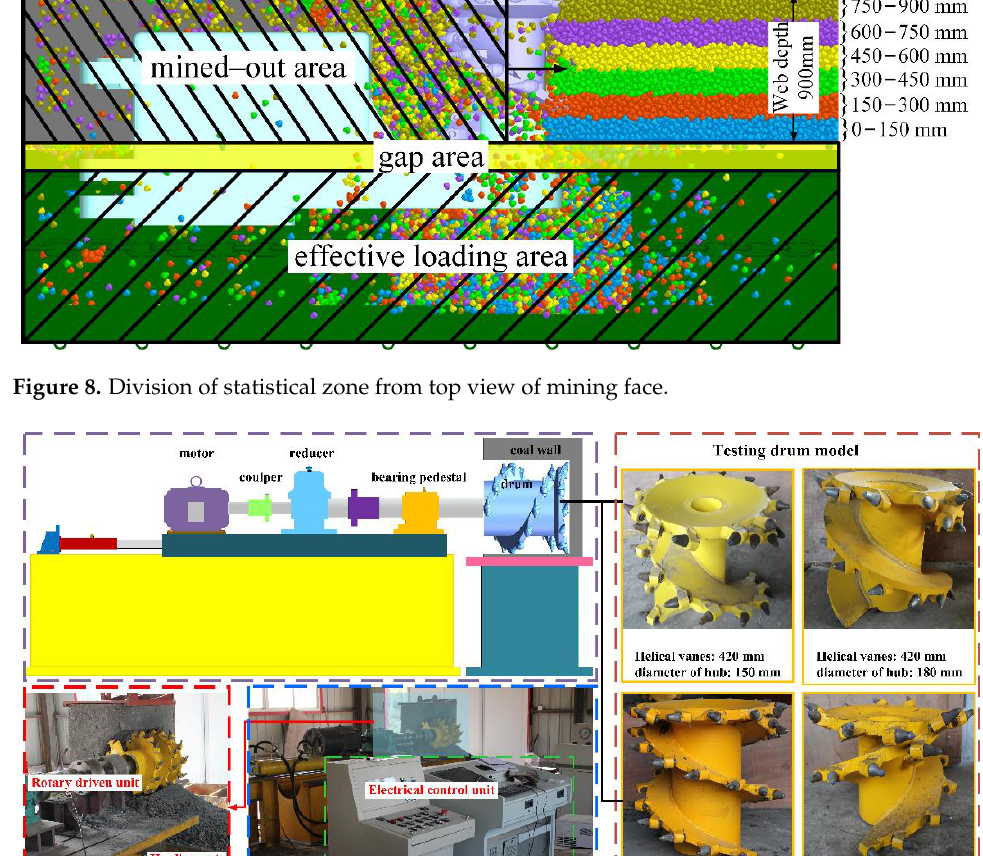
Figure 8. Division of statistical zone from top view of mining face.